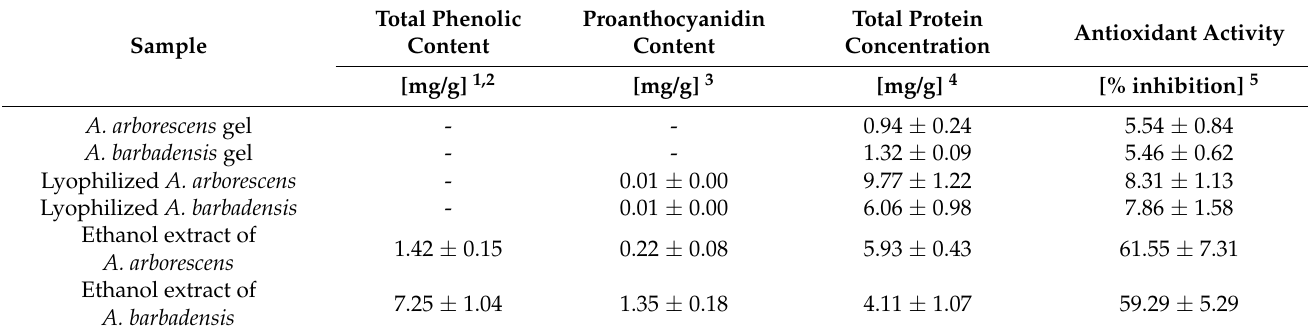
Table 2. Bioactive compounds content in A. arborescens and A. barbadensis samples and their antioxidant